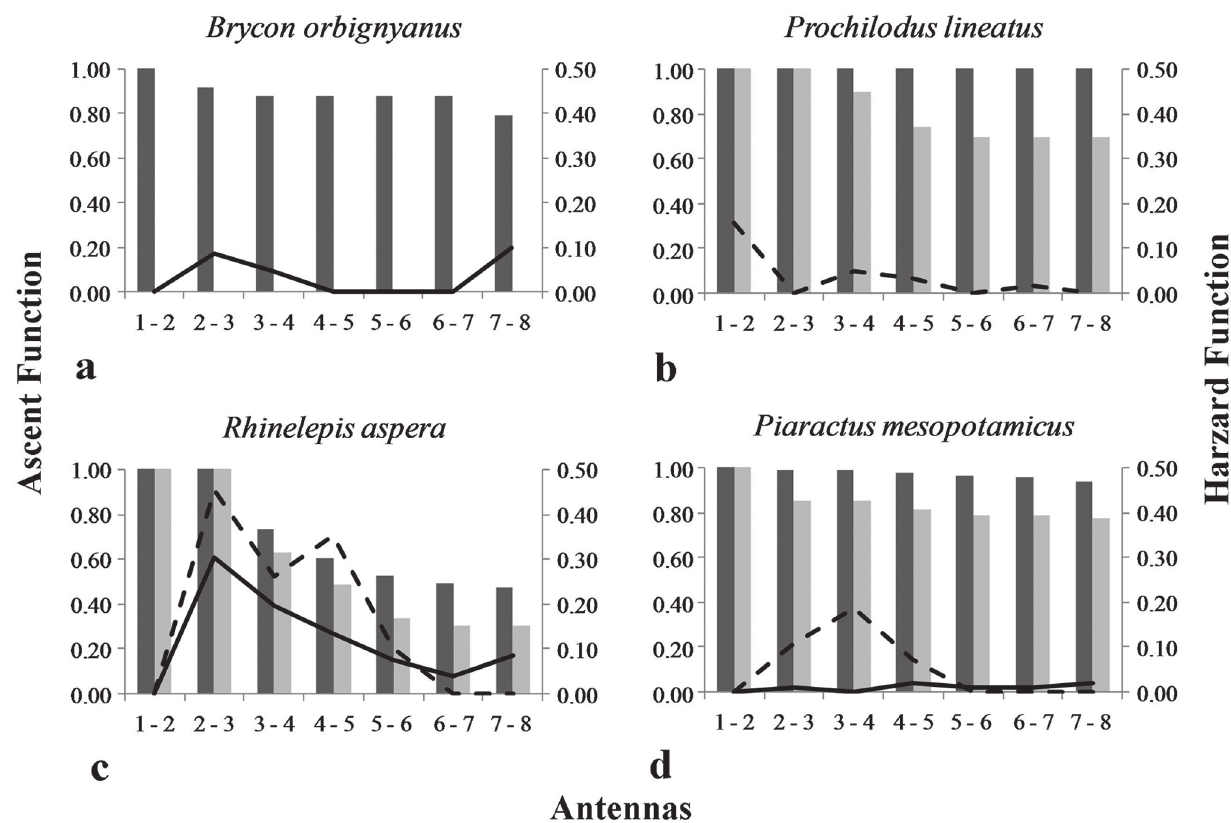
Fig. 5. Ascension probabilities (bars) and failure rates (hazard function, lines) through antennas in the fish ladder for four fish species released downstream (dark gray bar; solid line) and in the fish ladder (gray bar; dashed